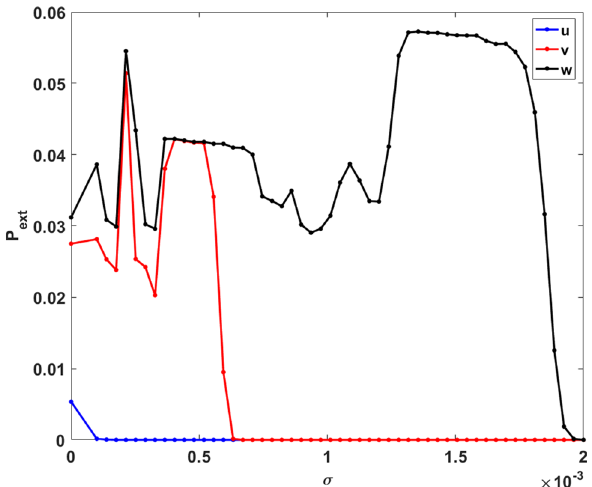
Figure 12. Probability of obtaining extreme events in unit time ( P ext ) of the system (3) with respect to the noise strength σ . Here we also consider a extreme event occurs when population level cross the µ + 7 σ threshold. P ext for vegetation, prey and predator populations are shown by blue, red and black colour